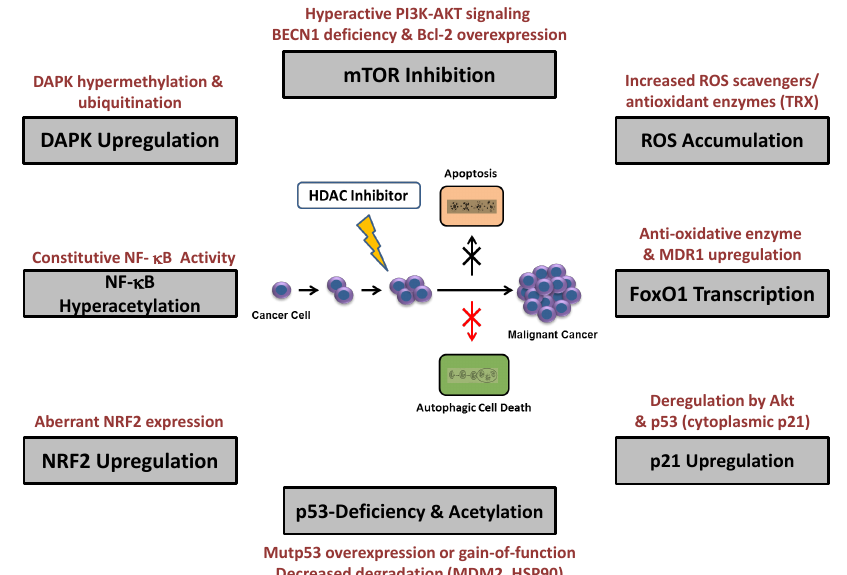
Figure 2. Di ff erent mechanisms of histone deacetylase (HDAC) inhibitor-induced autophagy (grey boxes) and presumed molecular determinants that cause resistance (red font). As many cancer cells already block many pathways leading to apoptosis (black arrow), which cannot be reversed by HDACi treatment, the additional occurrence of resistance to autophagy or the additional use of autophagy inhibitors (red arrow) eventually facilitates cancer cell survival. BECN1, BECLIN-1; Mutp53, mutant p53; MDM2, mouse double minute 2; HSP90, heat shock protein 90; TRX, thioredoxin; MDR1, multiple drug